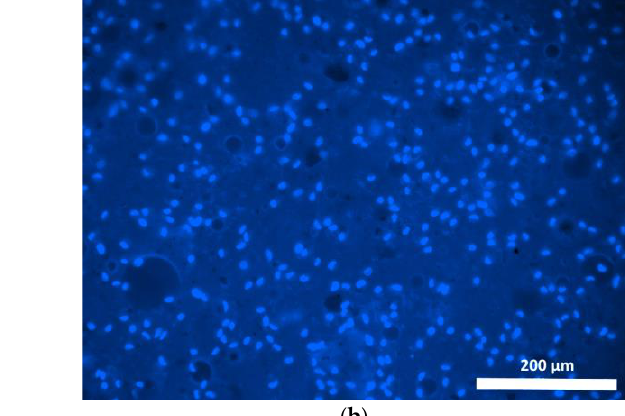
( b ) Figure 12. Viable fibroblasts on the surface of Composition 4 specimen (fluorescence microscopy, fluorochrome — Calcein AM (BD Pharmingen ™ ): ( a ) 24 h cultivation; ( b ) 72 h cultivation. Mag.100×. Furthermore, dilution of the 7-day extract of the zirconium-containing composition showed a positive effect on the proliferation of the test culture cells. However, some in- consistency in the data obtained requires a more detailed study of the zirconium-contain- ing compositions in order to assess their suitability as the basis of osteoplasty materials. The positive qualities of zirconium-based materials, such as their high biocompatibility, mechanical strength, and corrosion resistance, are known [82], and their inclusion into osteoplasty materials is being actively investigated. It has been shown that introducing zirconium compounds into the material structure, while improving its biocompatibility, prevents biofilm formation. Its cause is the evident bactericidal activity of such com- pounds against a wide range of microorganisms, including various strains of Staphylococ- cus aureus [83 – 86]. A number of studies have demonstrated zero cytotoxicity for materials coated with ZrO 2 [86 – 89], e.g., according to Zhang et al., 2012, the cytotoxicity of materials coated with zirconium oxide is no higher than ranks 1 or 2 [89]. Thus, our data are similar to the literature data and confirm the potential value of Composition 4, containing zirco- nium. 4. Conclusions The presented study demonstrates an investigation of the biological characteristics of polyurethane polymers with different radiopaque filler compositions, when used with